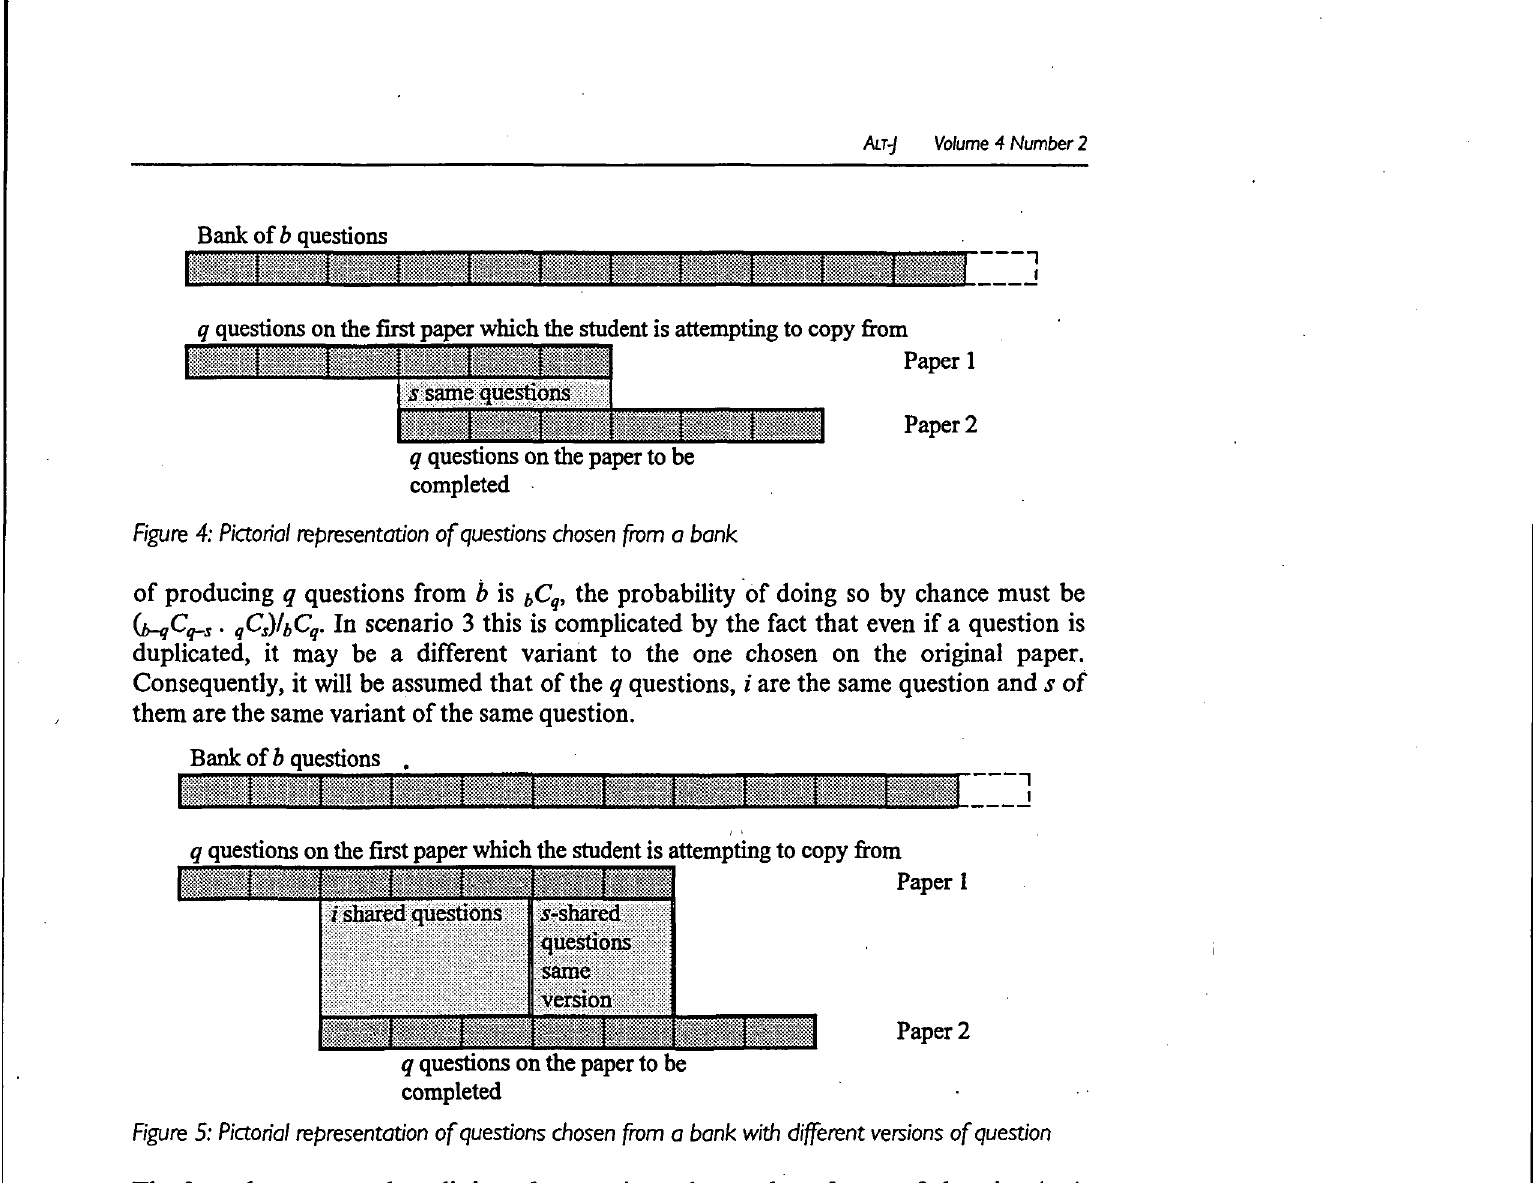
Figure 5: Pictorial representation of questions chosen from a bank with different versions of question The formula must now be split into three sections: the number of ways of choosing (q-i) non-duplicated questions from (b-q) questions, multiplied by the number of ways of selecting (is) duplicate questions but different variants from q questions, times the probability of that event, multiplied by the number of ways of selecting s questions from the remaining (q-(i-s)) questions, times the probability of that event. Now the equation must be summed for all possible values of /, and divided by the total number of ways of choosing q questions from b. This gives a probability of any two papers sharing s 'identical' questions